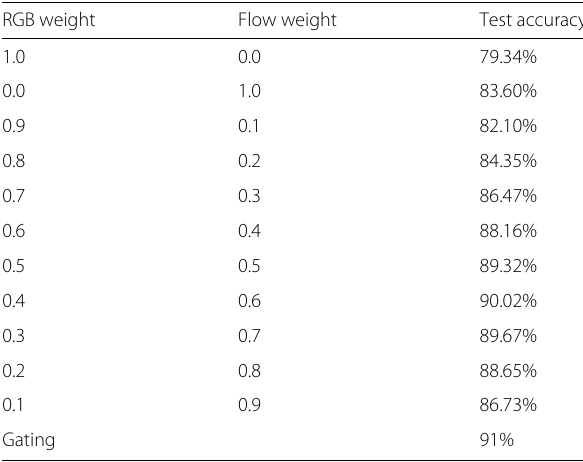
Table 7 Gated good practice for two streams trained by [12] on UCF-101 (split 1)